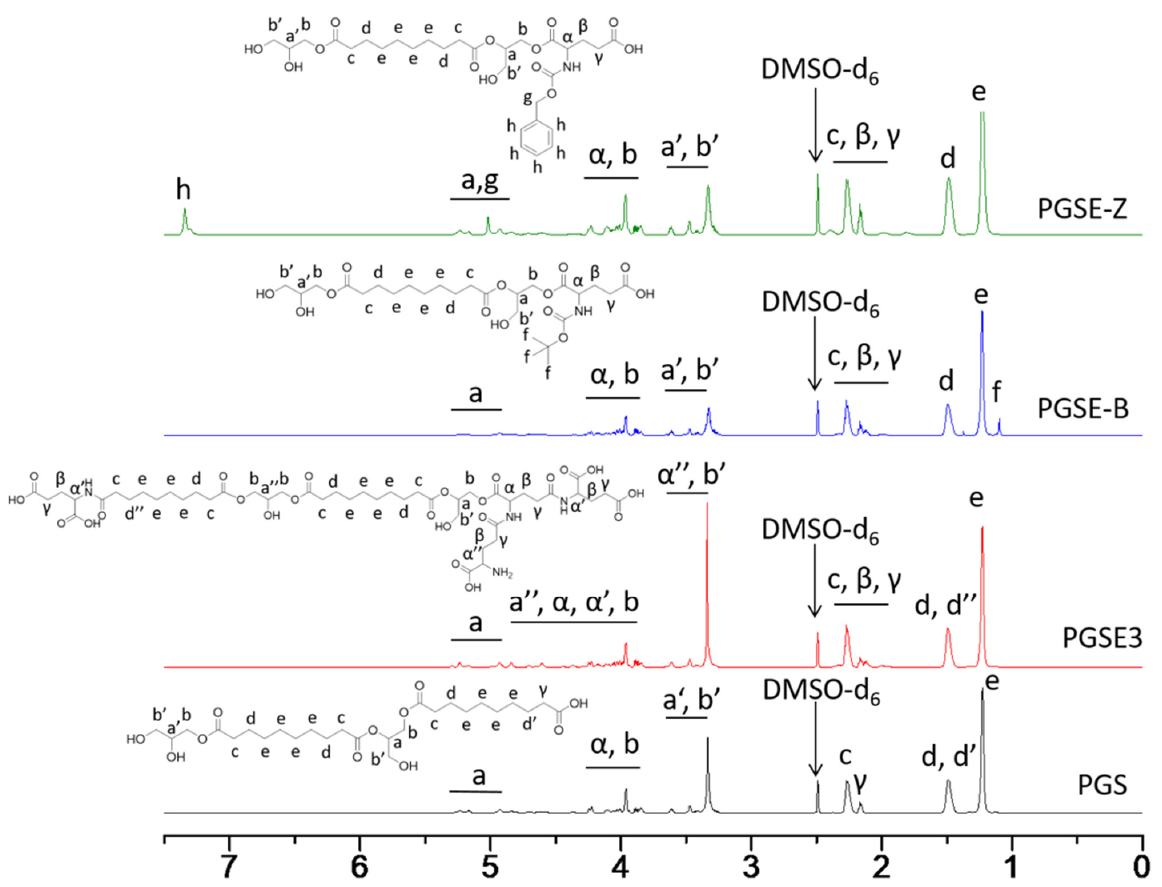
Figure 1. 1 H-NMR of the prepolymers for PGS, PGSE3, PGSE-B, and PGSE-Z.